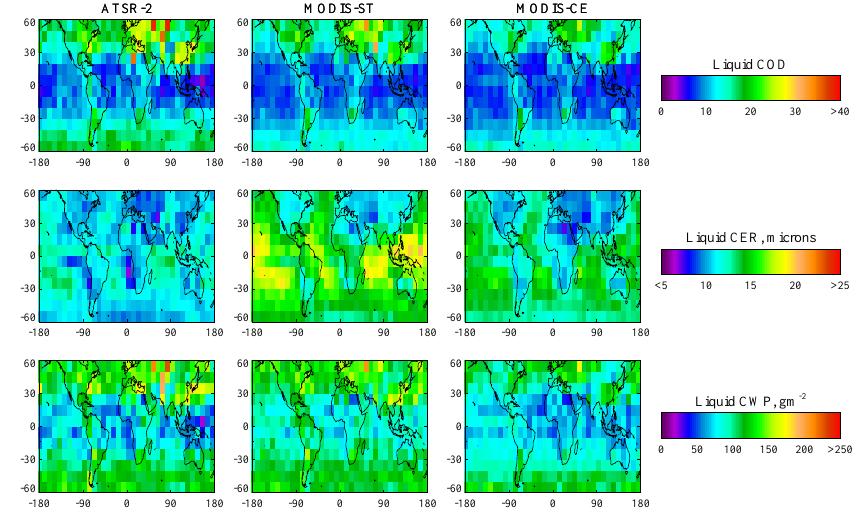
Fig. 13. Comparison between annual mean (colocated data for the year 2001) liquid water cloud properties derived from ATSR-2 and MODIS-Terra. The left column shows data from ATSR-2, the centre column MODIS-ST, and the right column MODIS-CE. From top to bottom, plots show the cloud optical depth, cloud effective radius, and cloud water path.